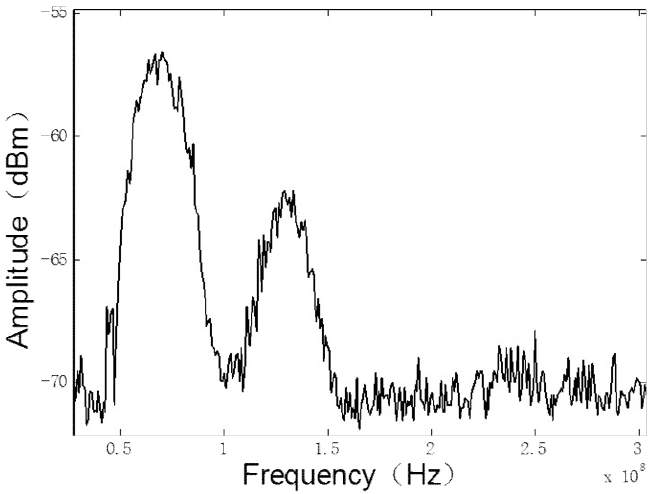
Figure 8. Frequency spectrum of discharge radiation signal of the double-needle discharge structure.